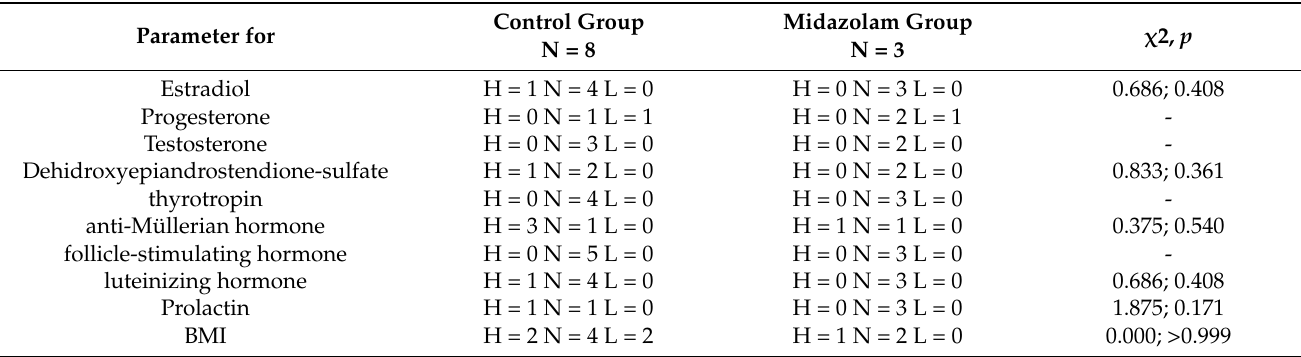
Table 2. Hormonal status of pregnant